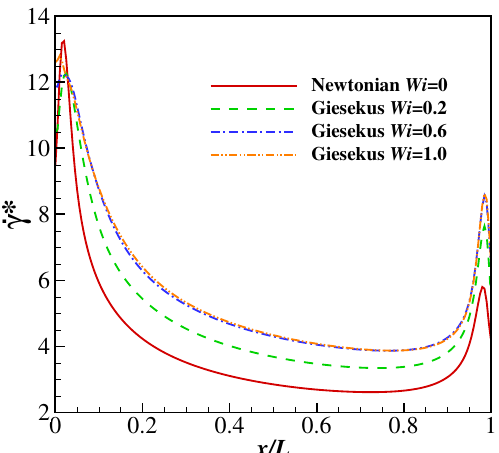
Figure 10. The non-dimensional shear rate ˙ γ ∗ = ∂ u x Wi = 0, 0.2, 0.6 and